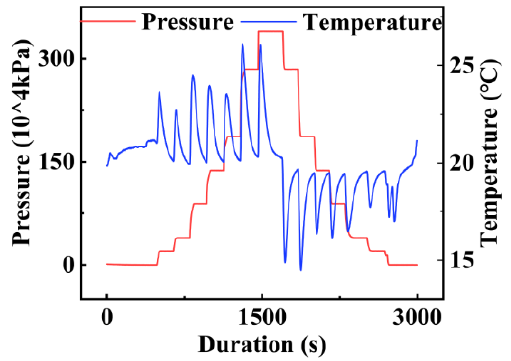
Figure 20. Comparison of the temperature and pressure results of the pressure calibration experi- ment.